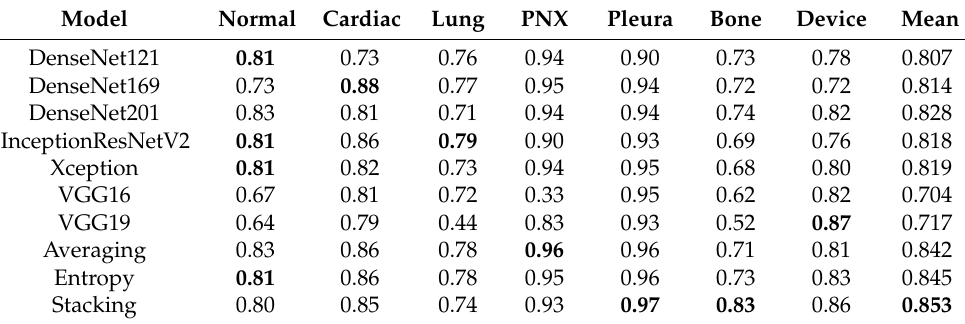
Table 7. CNN results with fine tuning of the classification layer of pretrained networks in terms of AUC. Each column represents an HUM-CXR finding. We report the results for each single network, for the two ensembling strategies, and for stacking. The best results for each class and average are highlighted in bold. Model Normal Cardiac Lung PNX